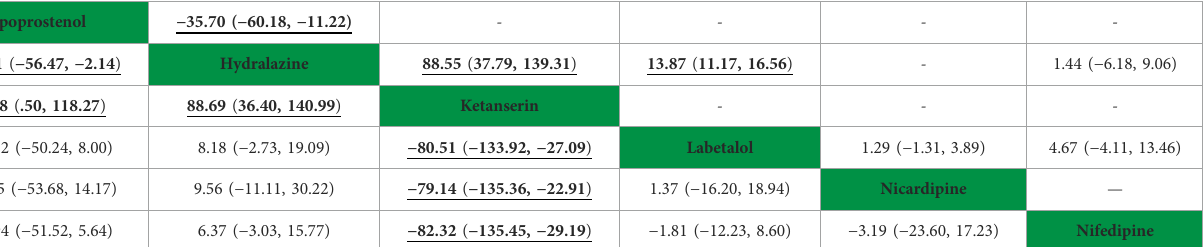
TABLE 3 Network comparison and direct comparison results for time required to reach the target blood pressure (min). Epoprostenol